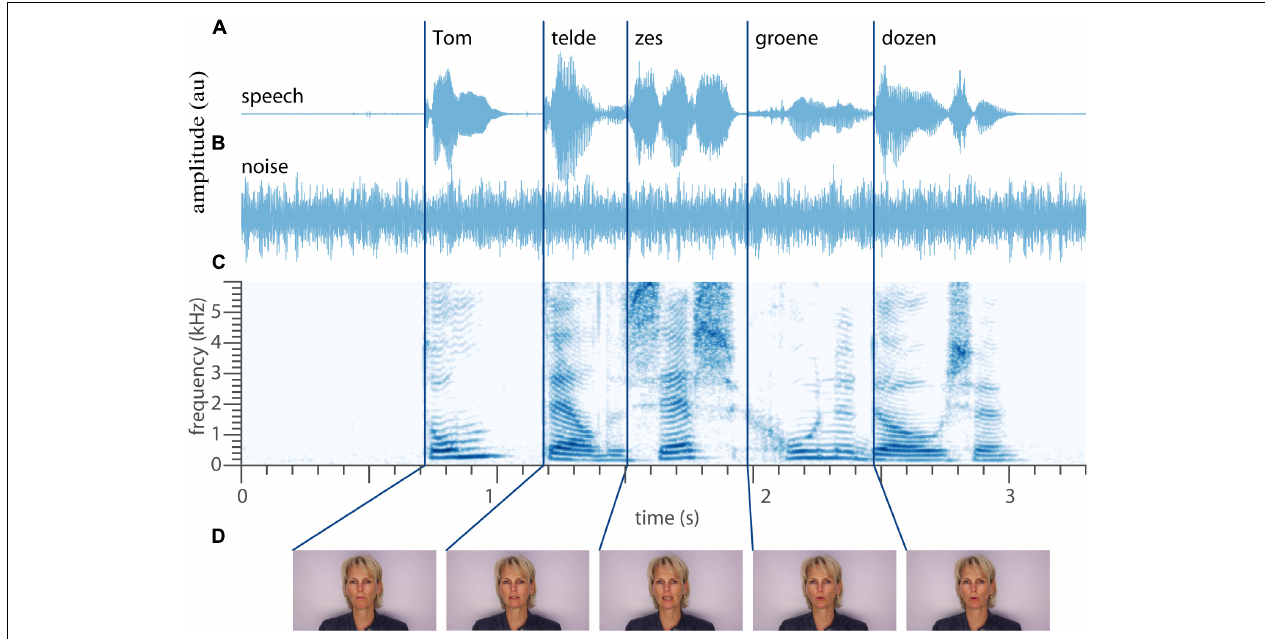
FIGURE 1 | Example stimulus. (A) Temporal waveform of the auditory speech signal “Tom telde zes groene dozen” (translation: Tom counted six green boxes.) (B) Waveform of the auditory noise. (C) Spectrogram of the recorded sentence. (D) Five videos frames around the onset of the word. Dark blue lines denote the approximate onset of each individual word. Written informed consent for the publication of this image was obtained from the individual